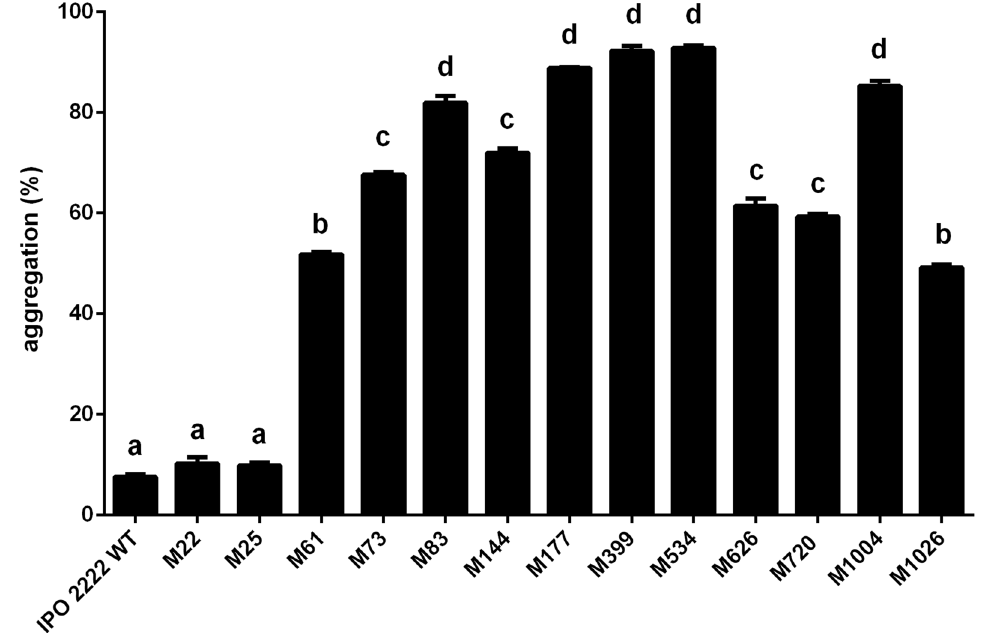
Figure 5. Self-aggregation of cells of WT and phage-resistant D. solani mutants as measured by turbidity of bacterial suspensions. The percentage of aggregation was quantified from the change in optical density (OD600) over 24 h. Percentage aggregation (sedimentation) was measured as follow: %A = 1 (OD600 24h /OD600 0 h ), where: %A—percentage of aggregation (sedimentation), OD600 0h —OD of bacterial culture at time 0 h, OD600 24h —OD of bacterial culture at time 24 h. Results were considered to be significant at p = 0.05 and pair- wise differences were obtained using the t-test. Error bars represent standard deviation